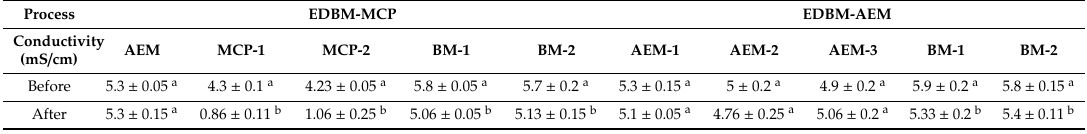
Table 2. Conductivity (mS/cm) of MCP (monovalent cation perm-selective membrane), AEM (anion exchange membrane) and BM (bipolar membrane) before and after treatment in EDBM-MCP and EDBM-AEM.